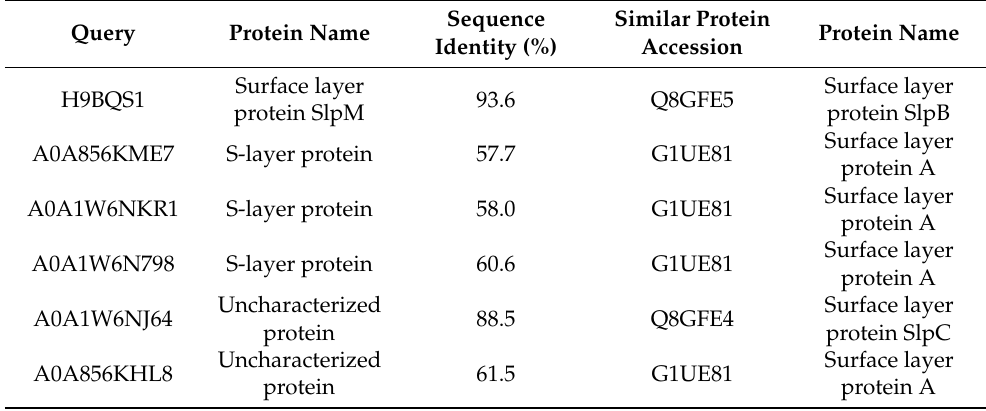
Table 2. BLAST analysis of the Slps identified in the five L. brevis strains. Query Protein